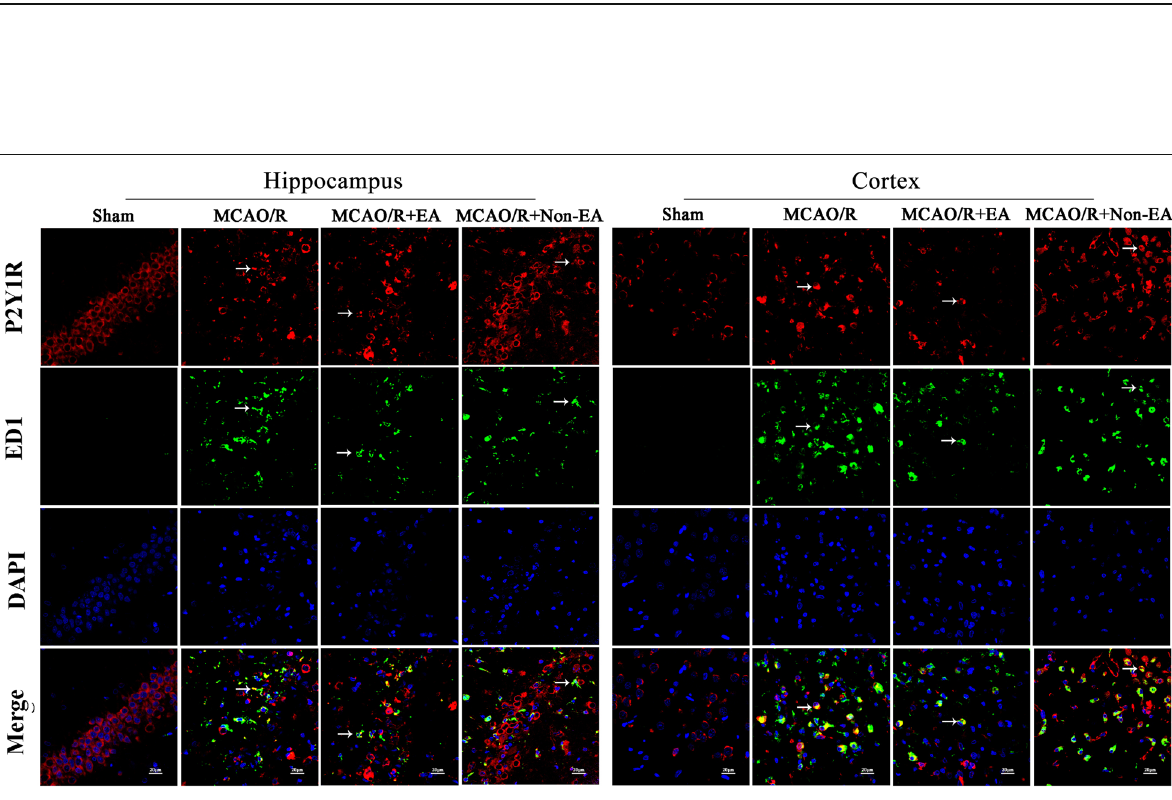
Fig. 8 Effects of EA on P2Y1R and GFAP co-expression after MCAO/R injury. The co-expression of P2Y1R and GFAP was examined in the hippocampal CA1 and sensorimotor cortex at Day 7 after EA. P2Y1R-positive cells are green. GFAP-positive cells are red. P2Y1R and GFAP double-positive cells are yellow. The arrows indicate the co-expression of P2Y1R and ED1. Nuclei counterstained with DAPI (blue). Scale bar 20 μ